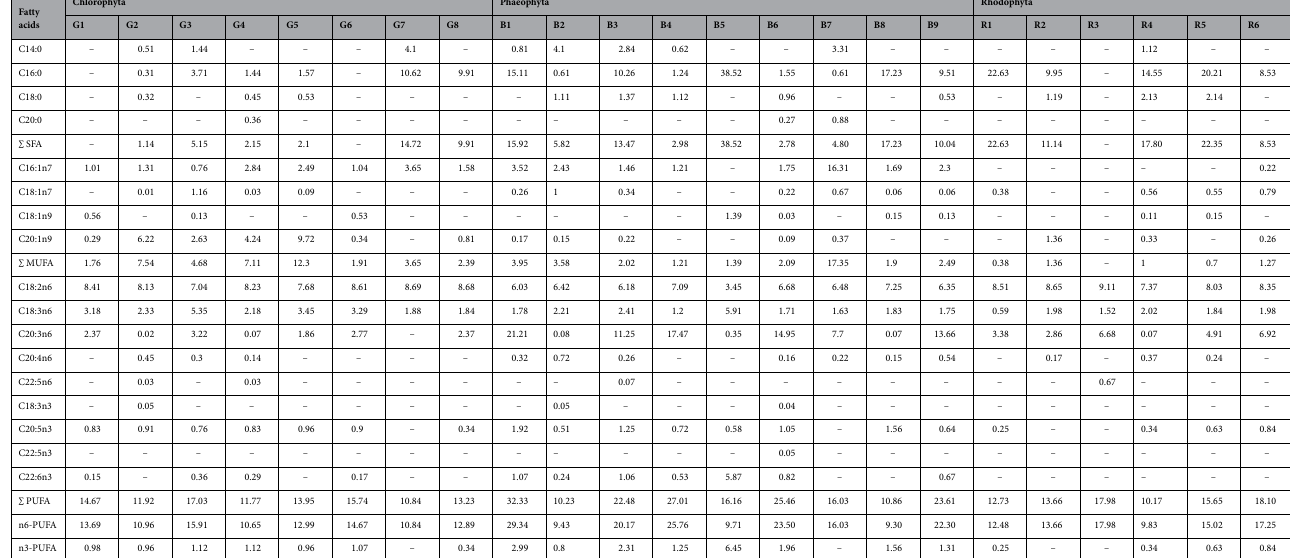
Table 4. The percentage as a mean value of fatty acid composition for each seaweeds species. (G1) Ulva lactuca , (G2) Caulerpa racemosa, (G3) Halimeda opuntin , (G4) Caulerpa racemosa , (G5)